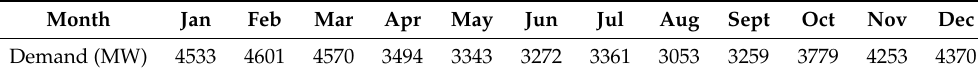
Table 3. Energy demand of Grand-Est for 2018 [51].